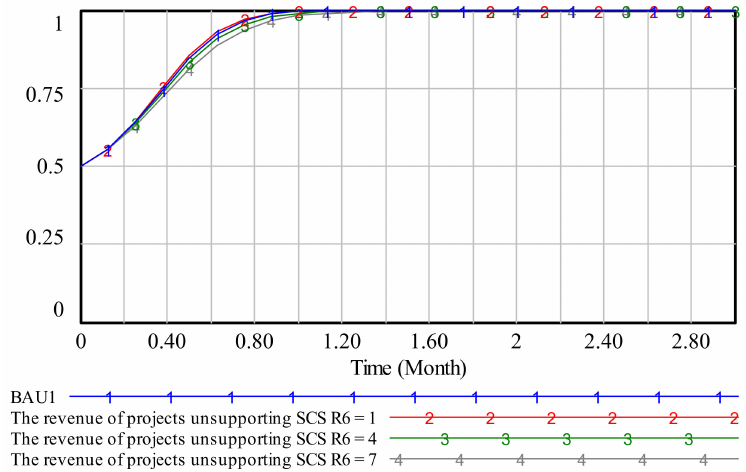
Figure 11. Impact of R 6 on enterprise strategy selection in the BAU1 scenario.